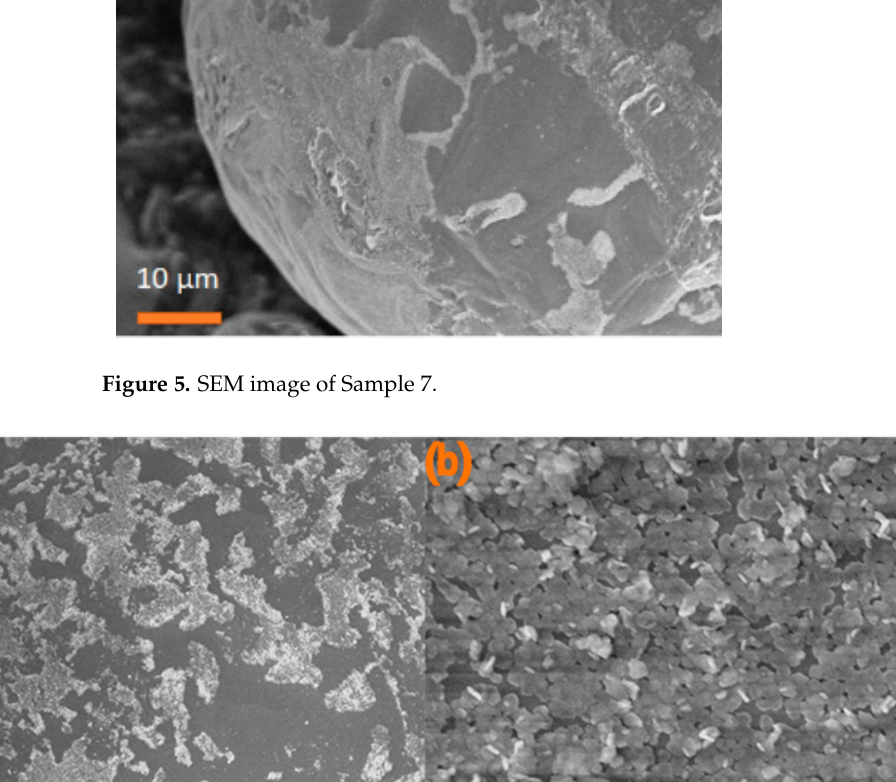
Figure 6. ( a ) SEM image of Sample 8 and ( b ) the magnification of ( a ).